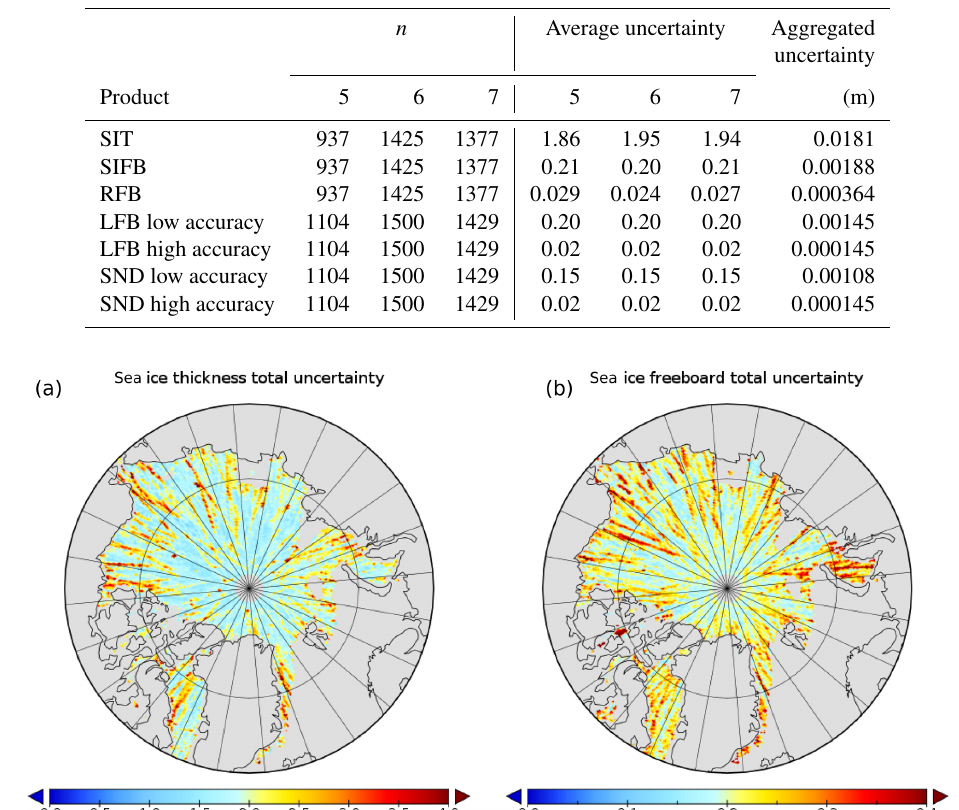
Table 2. Overview on data sets, the # of sampled EASE 2.0 grids in control regions 5–7 (columns 2–4), the respective average uncertainties (columns 5–7), the uncertainty of the product aggregated over all sampled EASE 2.0 grid cells (column 8).